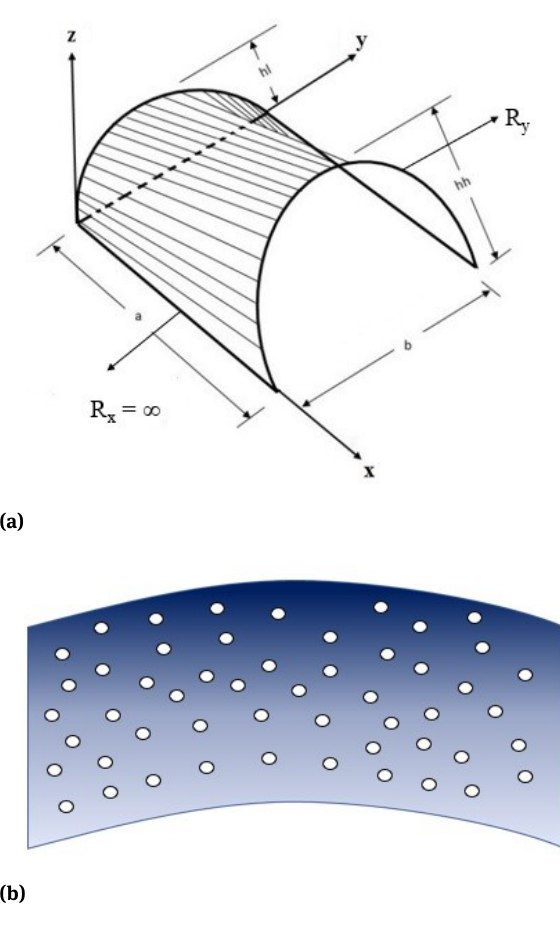
Figure 1: (a) Geometry of conoidal shell and (b) porosities models for even porosity in thickness